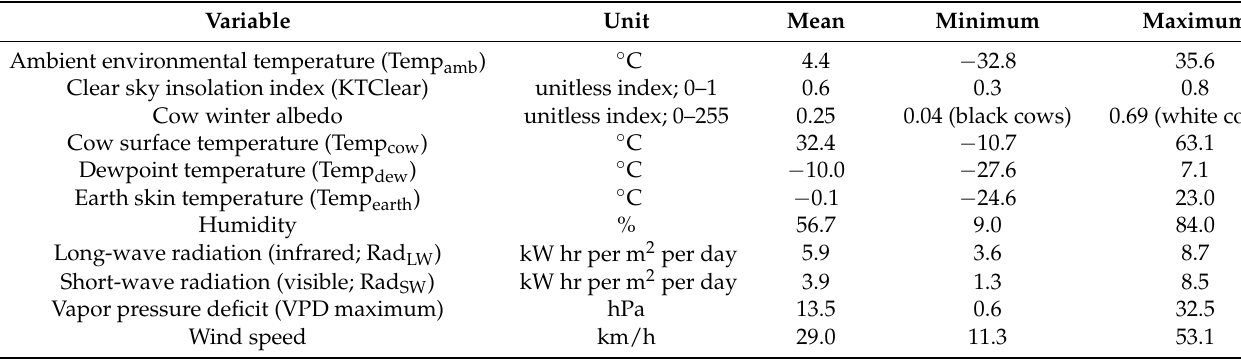
Table 2. Units, means, minimums, and maximums of potential predictor variables and associated justification for inclusion for modeling external surface temperatures of red, white, and black hided cattle (Temp cow ) and then the difference ( ∆ T) between Temp cow and the ambient temperature of the surrounding environment (Temp amb ). Variables are listed in alphabetical order. Cattle were white, red, and black Bos taurus cows free roaming on rangeland west of Laramie, WY, USA at the University of Wyoming, Agriculture Experiment Station, Laramie Research and Extension Center—Beef